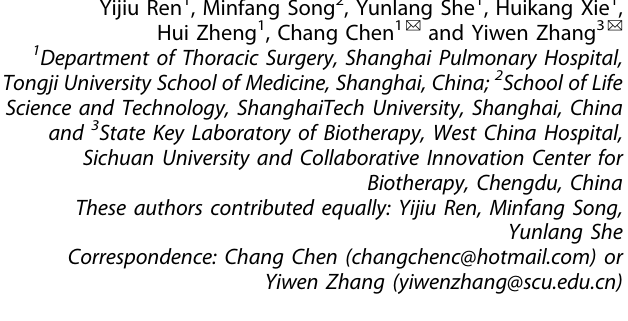
Fig. 1 The molecular pro fi ling identify intra-tumor subclonal heterogeneity. a Schematic of the fi ve synchronous multiple ground-glass nodules for the whole-genome sequencing. The left side shows the location of all lesions in the lung models, with colorful dots representing the lesions. The middle side shows the CT scans of all lesions, with the yellow block chart showing the exact locations of the lesions. The right side shows the pathology sections of all lesions. P represents each patient. b , c Heatmap and plot of the somatic copy number variations of the fi ve synchronous multiple ground-glass opacity lesions for the whole- genome sequencing. In the heatmap, the horizontal coordinates represent lesions, whereas the vertical coordinates represent chromosomes, with the red bar representing copy number gain and the blue bar representing copy number loss. The Pearson correlation coef fi cients were calculated. d Deconstructing CNV and LOH types. Various types of copy number and LOH were inferred using Titan program. The CNV and LOH features were extracted from result fi les following the iterations of cellular subclonal cluster analysis that yielded the best clonal structure state. The same loci with the same types of features were compared for commonalities or uniquenesses across the paired SM-GGN samples. Allele-speci fi c copy number ampli fi cation (ASCNA), Balanced copy number ampli fi cation (BCNA), Unbalanced copy number ampli fi cation (UBCNA), One-copy gain (GAIN), copy neutral LOH (NLOH), Ampli fi cation LOH (ALOH), Hemizygous deletion LOH (DLOH), heterozygous (HET). e Clonal structure of AAH4 (left) and AD4 (right) of patient 4. Top panel: Copy number is represented as the log ratio of tumor and normal read depth. Discrete copy number status shown is predicted as either a hemizygous deletion (HEMD; green), copy neutral (NEUT; blue), or gain/ ampli fi cation (AMP; red). Middle panel: Allelic ratios are computed as the proportion of reads matching the reference genome. The LOH status shown is HET (gray), LOH (green), NLOH (blue), or ASCNA (red). Lower panel: the sample cellular prevalence estimates (proportion of sample) for a subclonal cluster ‘ Z1 ’ and ‘ Z2 ’ . f CNV/LOH features shared by subclones. g Somatic CNVs were detected using HHMcopy program for the low-depth WGS data, and the CNV segments are displayed as ampli fi ed CNV (red) and deletion CNV (blue) among chromosomes of all 10 GGN samples of 10 patients. h Various types of copy number and LOH were inferred by Titan program. The CNV and LOH features were extracted from result fi les following the iterations of cellular subclonal cluster analysis that yielded the best clonal structure state. The same loci with the same types of features were compared for commonalities or uniquenesses across the paired SM-GGN samples. i Clonal structure of MG1AAH (top) and MG1AIS (bottom) of patient MG1. Top panel: The sample cellular prevalence estimates (proportion of sample) for a subclonal cluster ‘ Z1 ’ and ‘ Z2 ’ . Lower panel: CNV/LOH pro fi les of subclones for HET (gray), LOH (green), NLOH (blue), or ASCNA (red). j CNV/LOH features shared by subclones of MG1